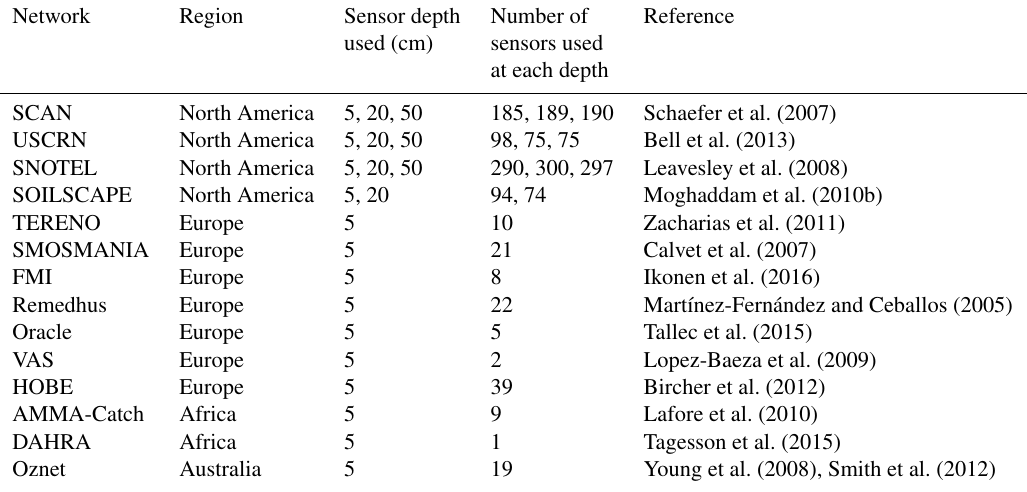
Table 2. In situ measurement networks used to evaluate soil moisture. The different columns contain the region and the name of the network, the depths of the probes used, and the bibliographic reference to the network.